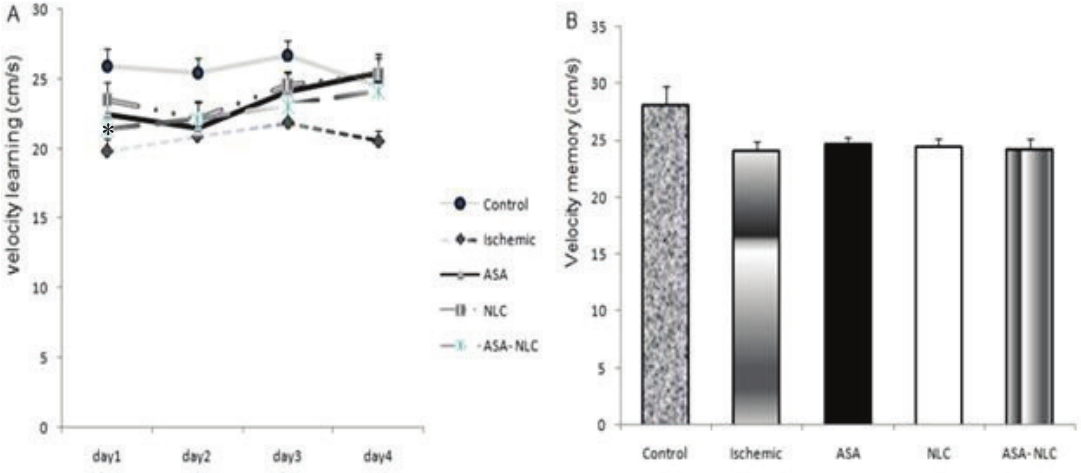
Figure 4: (A, B) Effects of aspirin and neural- like cell administration on swim speed (velocity) in learning and memory phase. Velocity learn- ing and memory in either of the groups remained significantly unchanged in consecutive days except for the ischemic group on the 1st day in learning phase. Data were expressed as mean ± S.E.M.